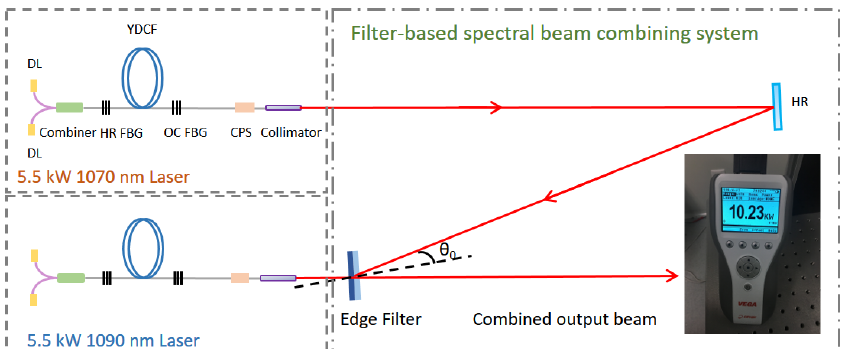
Figure 2. Experimental setup for a spectral beam formed from the combination of two high-power, broad-linewidth single beams. DL, diode laser; HR FBG, highly reflective fiber Bragg grating; OC FBG, output coupler fiber Bragg grating; YDCF, ytterbium-doped double-clad fiber; CPS, cladding power stripper; HR, high reflector [11,24].